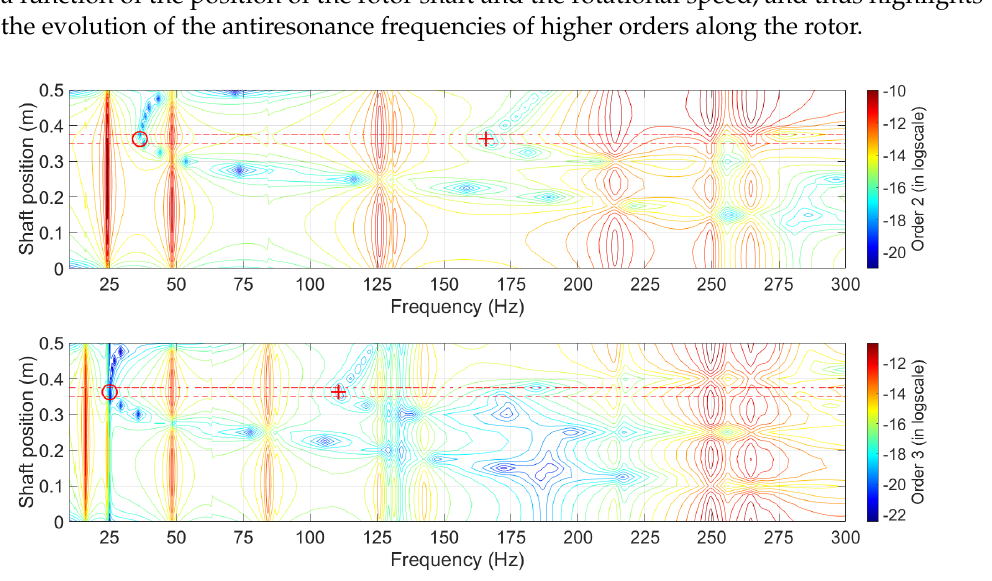
Figure 5. Case 1—Identification of the crack location based on the antiresonances of orders 2 and 3 (results are drawn for the vertical amplitudes in the log-scale).